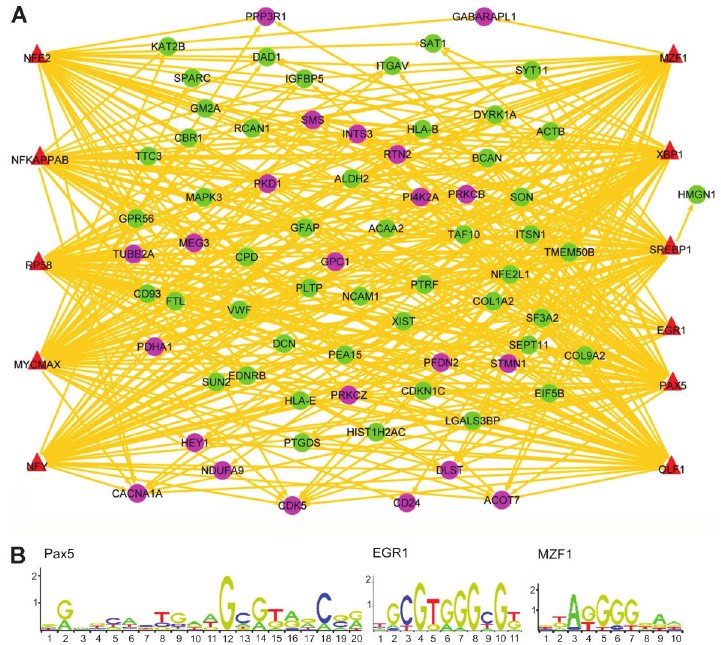
Figure 4. A , Transcriptional regulatory network of up-regulated or down-regulated genes. Red triangles denote transcription factors; green circles denote up-regulated genes; pink circles denote down-regulated genes. B , Significantly enriched transcription factor motifs of up-regu- lated or down-regulated genes in JASPAR